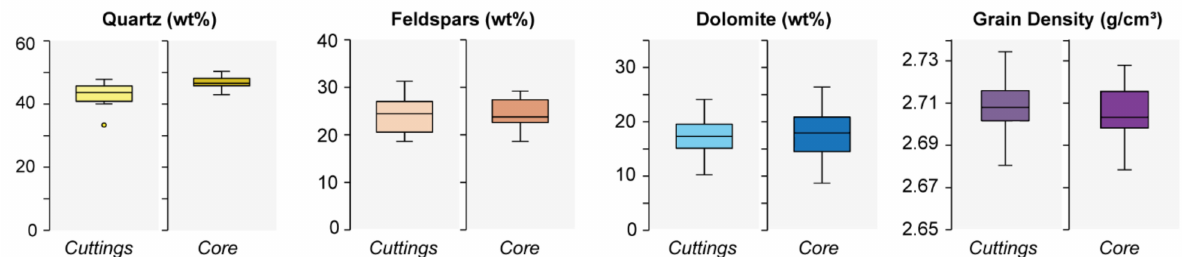
Figure 6. Box plots comparing the results from mineralogical and grain density analyses conducted on drill cutting samples from the horizontal well versus core plug samples from the vertical reference well. The data for the reference core are presented in Table 1.